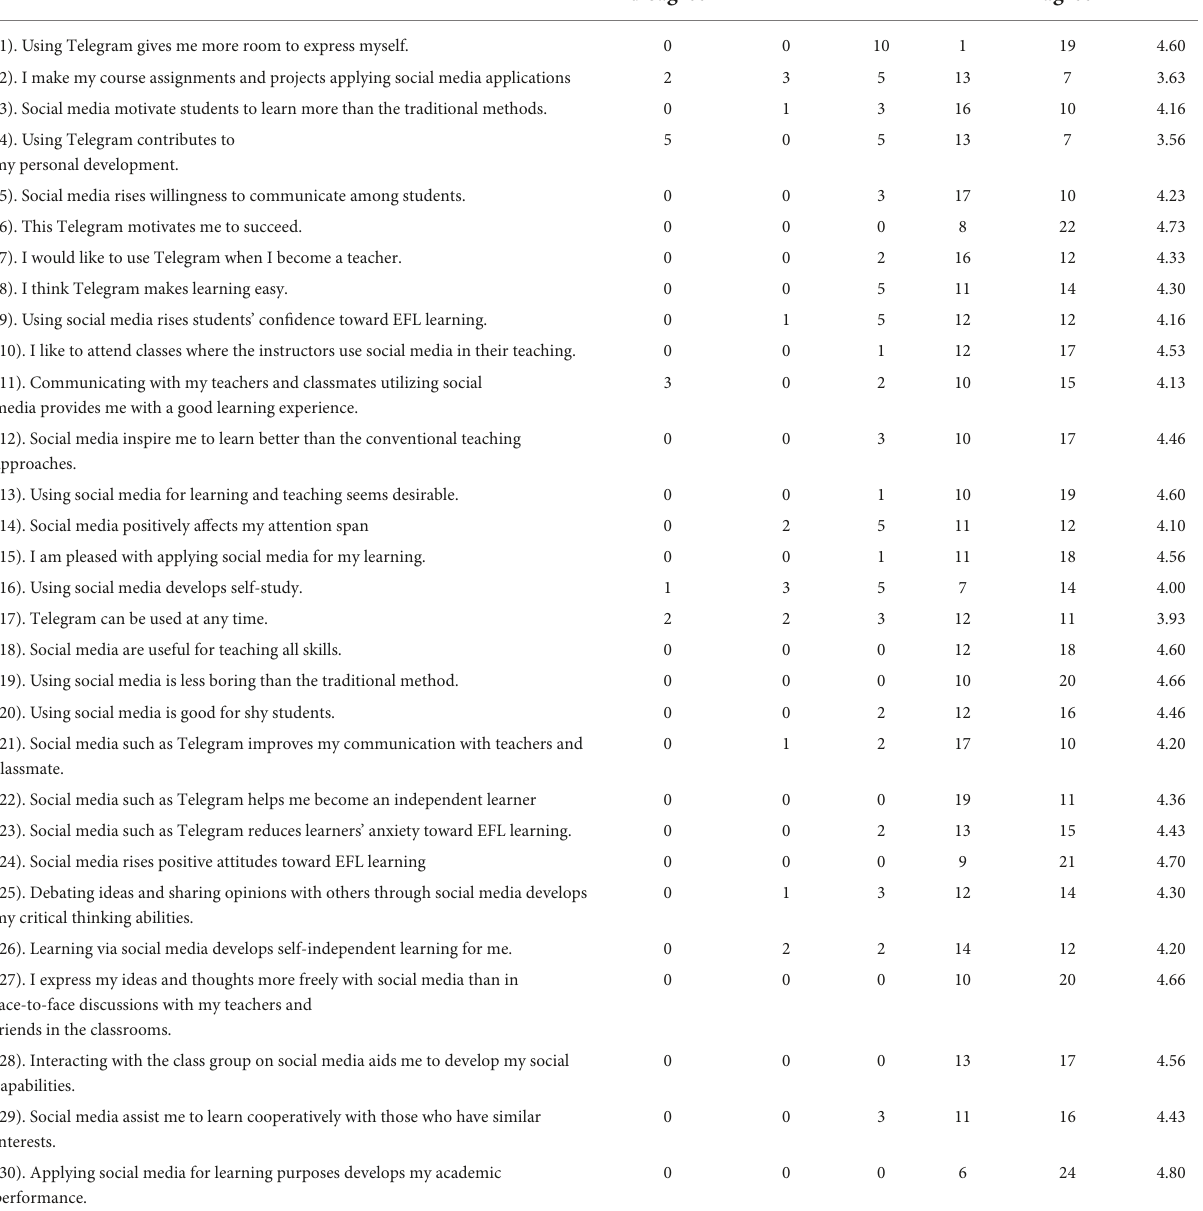
Completely Disagree No idea Agree Completely disagree